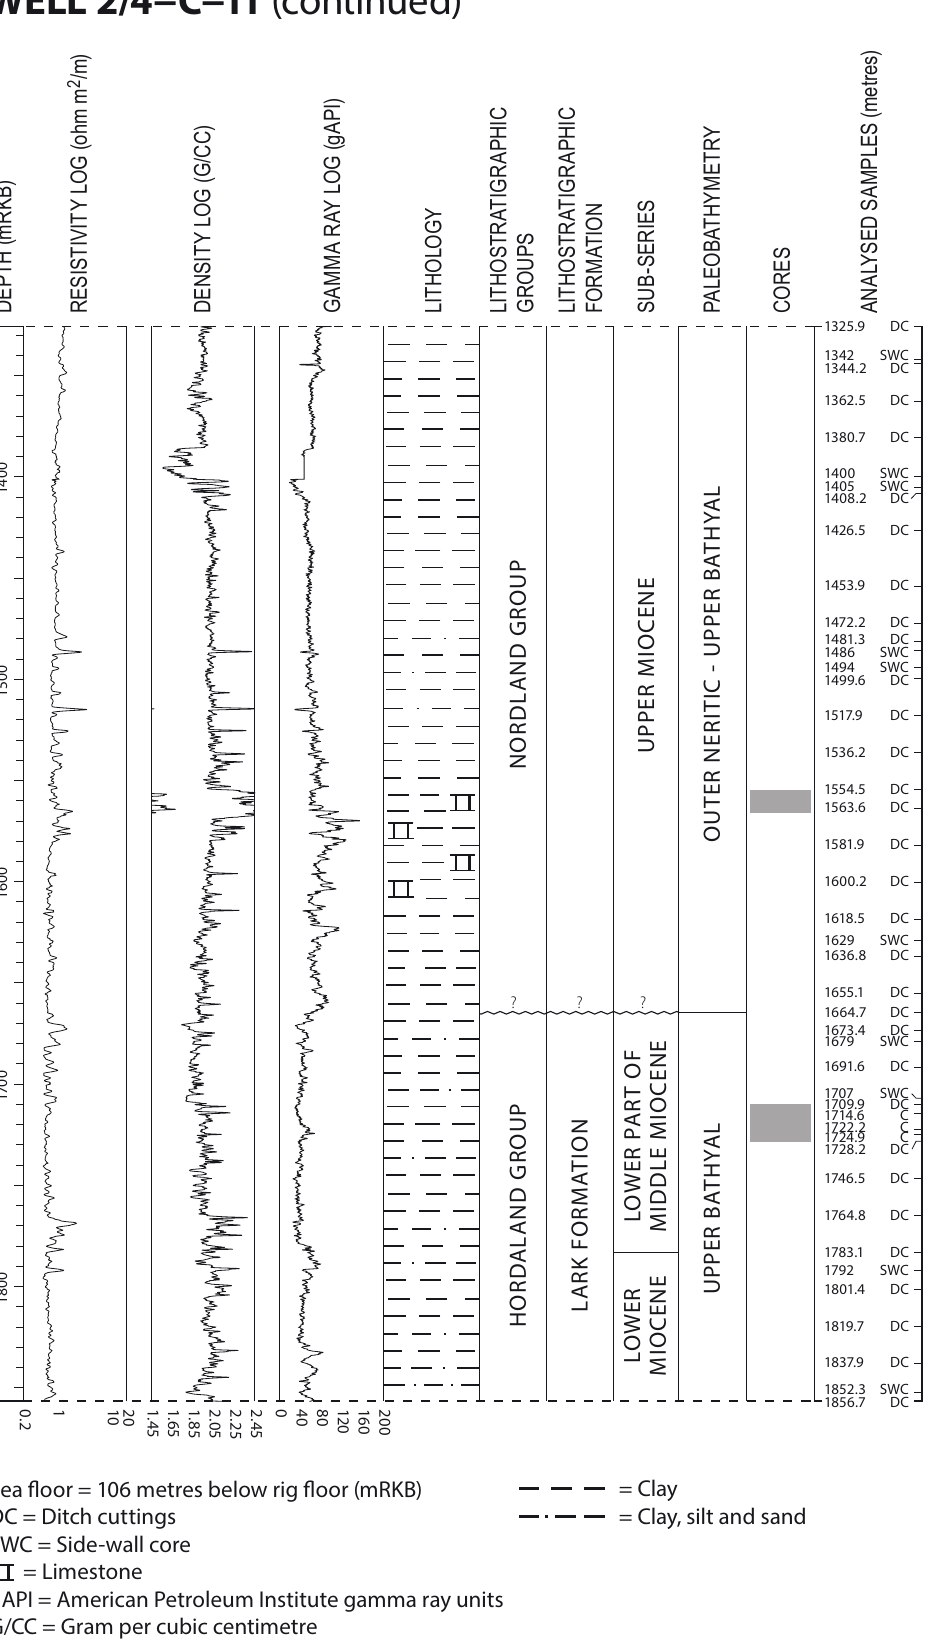
Figure 26. Well summary figure including resistivity log, density log, gamma-ray log, lithology, lithostratigraphic units, sub-series, paleobathymetry and analysed samples for the second upper portion of the investigated sequence in well 2/4–C–11 (lower Miocene (upper part) to upper Miocene (lower part)) including the supplementary well reference section for the Lark Formation (upper part; modified after Eidvin et al., 1999, 2013d).